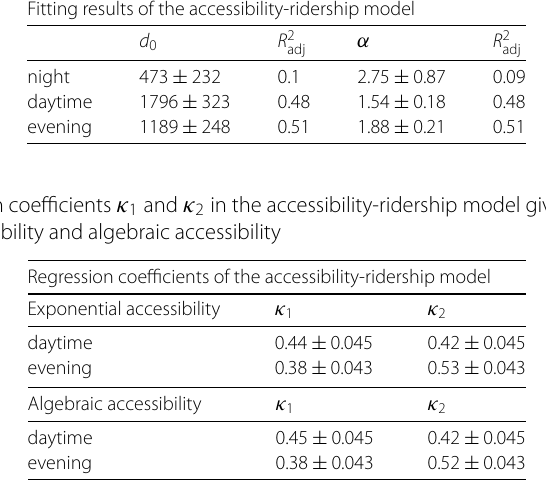
Table 2 Fitting results in the accessibility-ridership model given by Eq. (8). The first and second columns present the parameter of exponential accessibility and corresponding values of R 2 the third and fourth columns are devoted to algebraic accessibility Fitting results of the accessibility-ridership model